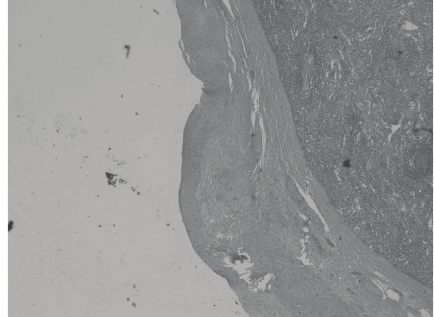
Figure 3: Wall of intrasplenic aneurysm showing all arterial layers. H&E 2x